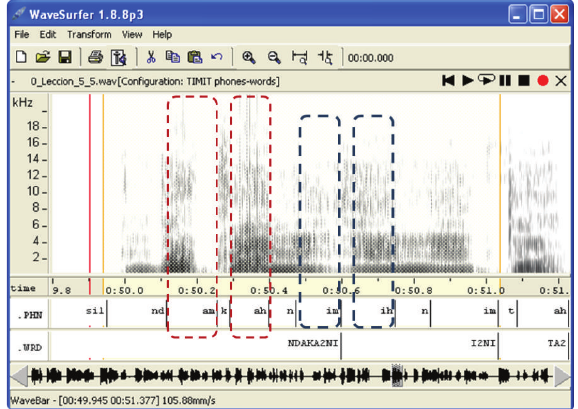
Figure 4: Orthographic and phonetic labelling of the Mixtec speech